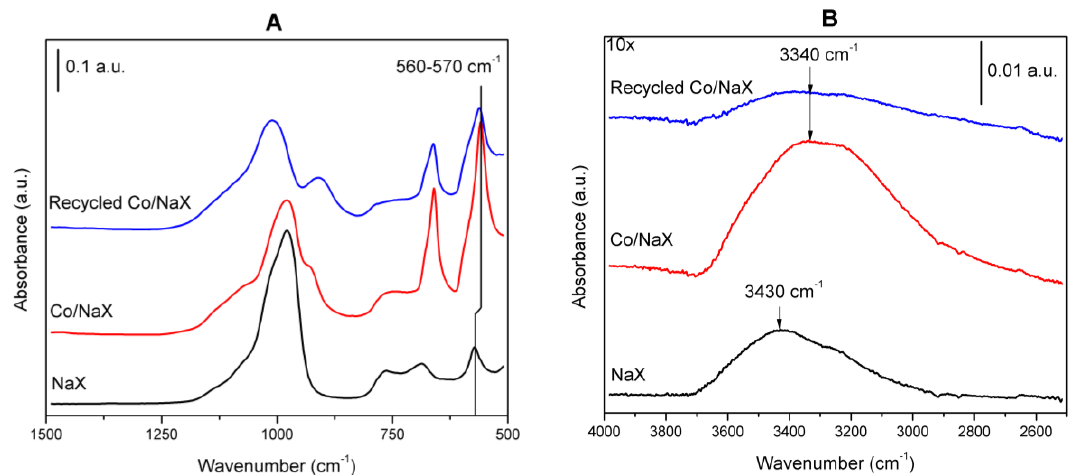
Figure 5. ATR-FTIR of the catalysts where ( A ) a large shift and increasing intensity of the band at 560 at 560 cm − 1 indicated ion-exchange of Na with Cobalt and ( B ) loss of the 3430 cm − 1 band cm −1 indicated ion-exchange of Na with Cobalt and ( B ) loss of the 3430 cm −1 band (10x magnification) (10x magnification) could indicate coke coverage of the hydroxyl could indicate coke coverage of the hydroxyl groups.